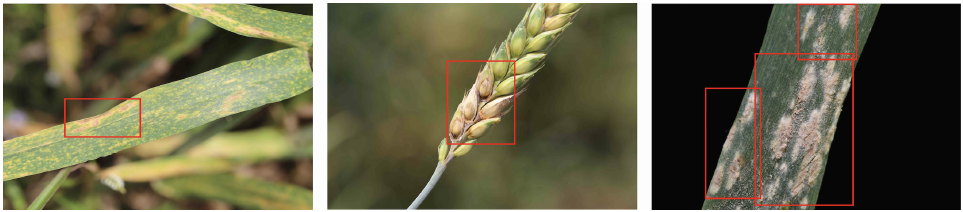
Figure 11. Illustration of object detection results. The red box indicates the location of the